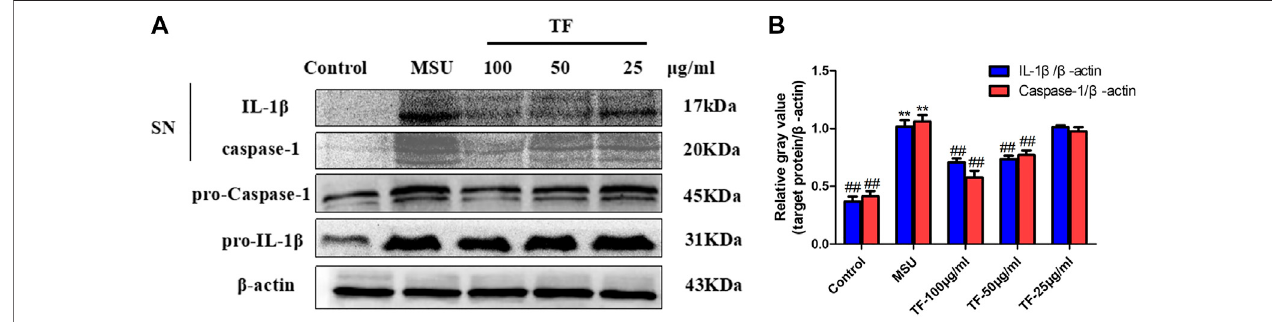
FIGURE 10 | Effects ofTF on IL-1 β and caspase-1 expression in LPS/MSU-induced THP-1 macrophages. (A) Immunoblot analysis of IL-1 β and active caspase-1 in supernatants and cell lysates of THP-1 macrophages treated with TF. (B) Relative gray value of target protein over β -actin. * p < 0.05 and ** p < 0.01, signi fi cantly different the normal control group; # p < 0.05 and ## p < 0.01, signi fi cantly different the LPS/MSU control group. SN, medium supernatants; TF, fl avonoid extract.